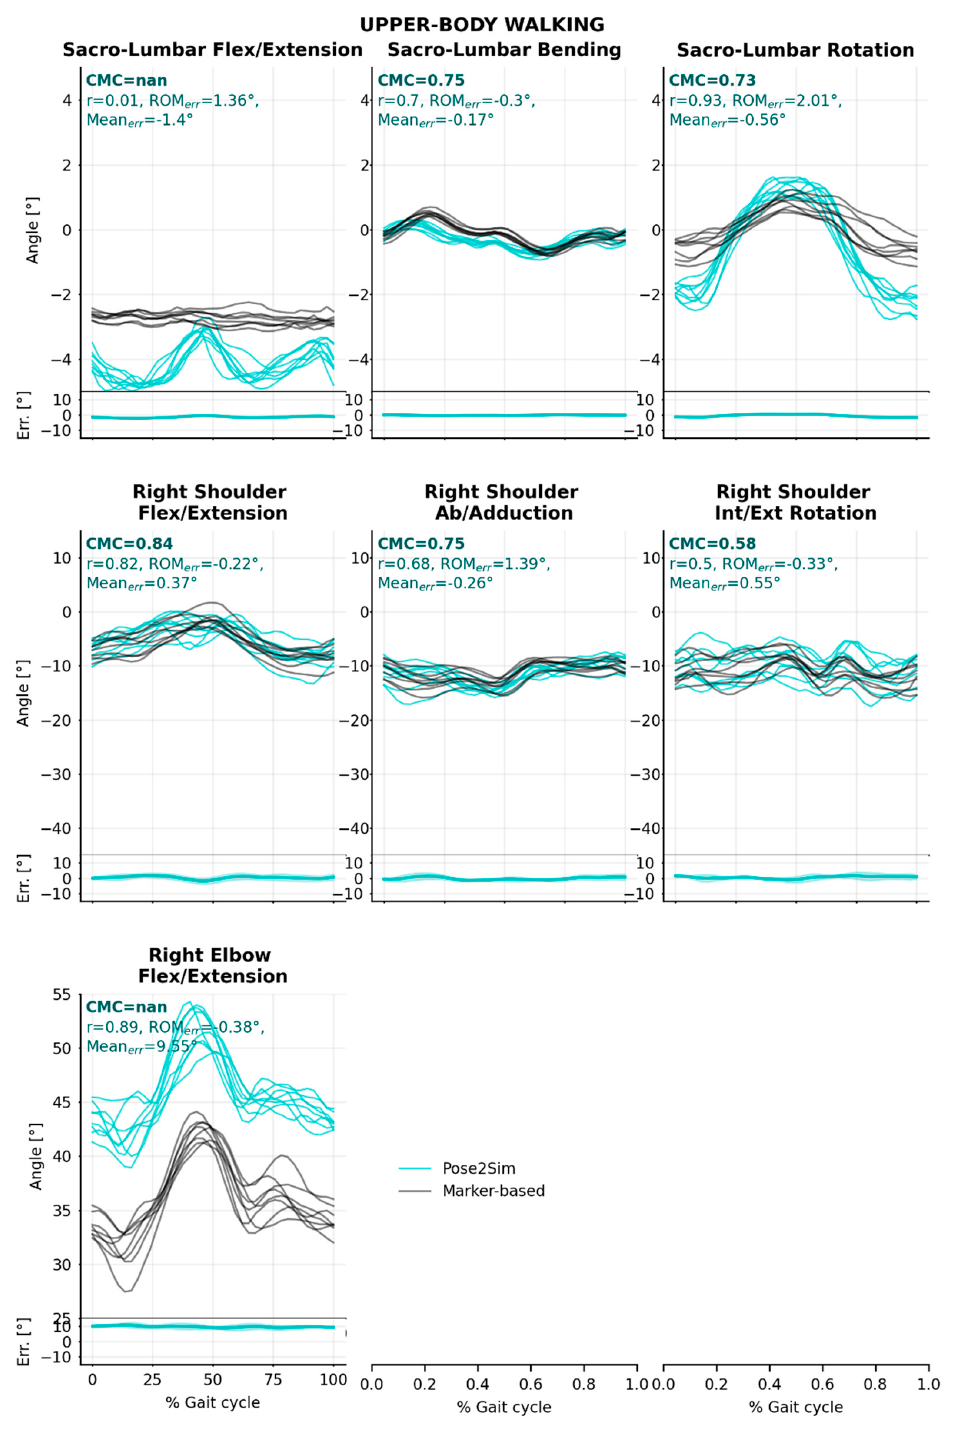
Figure A1. Pose2Sim (cyan) and marker-based (black) sacro-lumbar and upper-body joint angles for the walking task. Coefficient of multiple correlation (CMC) is indicated, and broken down into, respectively, Pearson’s coefficient (r) for correlation assessment, range of motion errors (ROM err ) for gain, and overall mean error (Mean err ) for offset. Mean error and standard deviations are also represented at the bottom of the graphics.